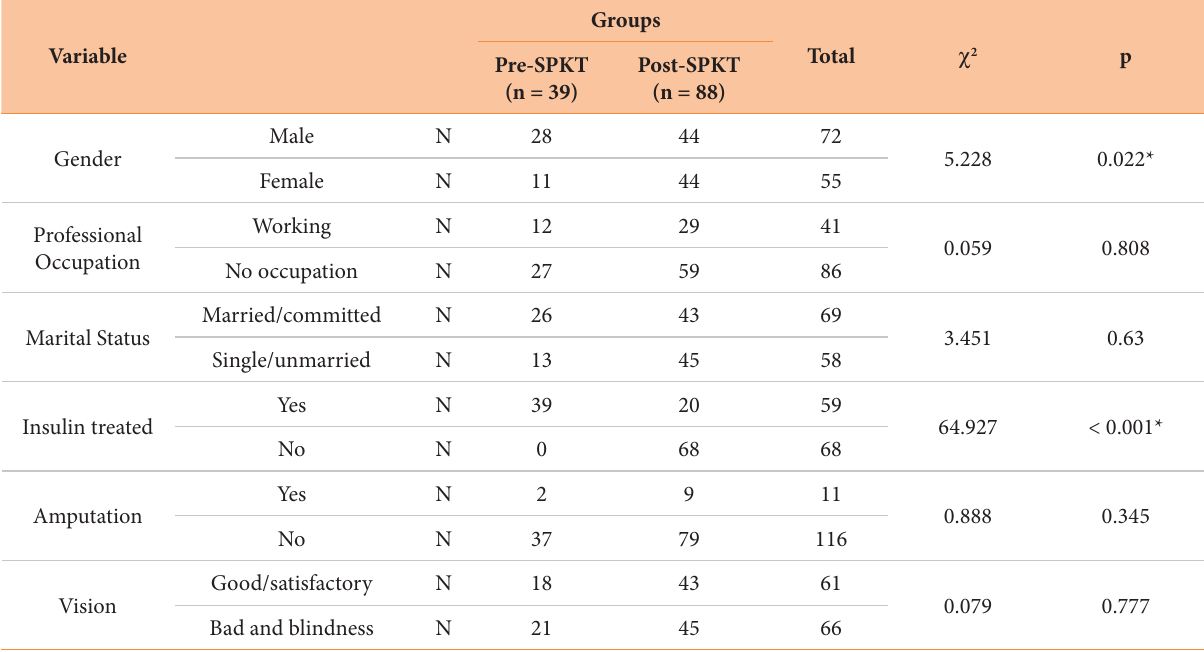
Table 1 - Demographic and clinical variables for pre- and post-SPKT